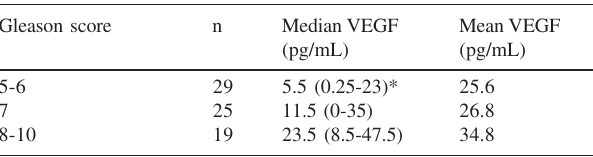
P = 0.18; * interquartile range